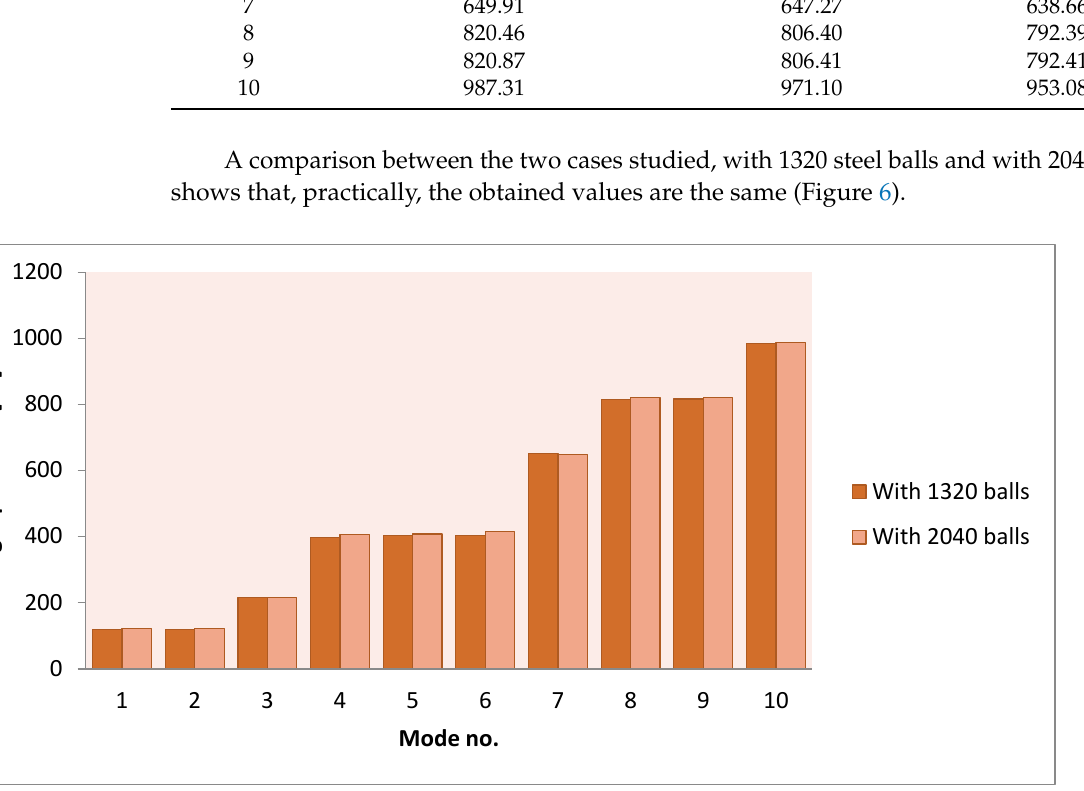
Figure 6. Comparison of the eigenpulsations obtained for the two studied models.